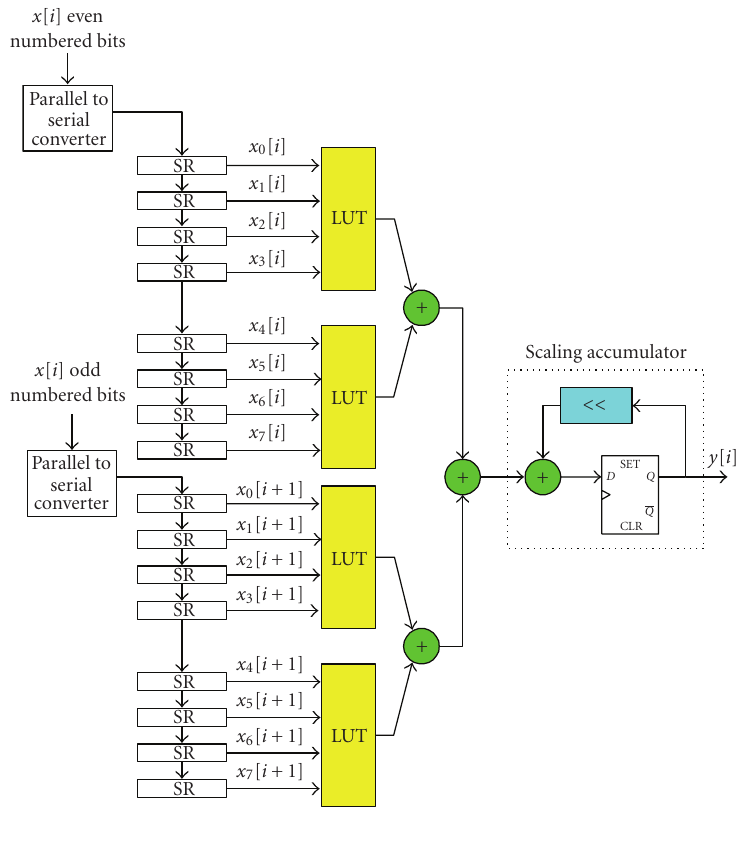
Figure 4: A 2 bit parallel DA FIR filter block diagram.